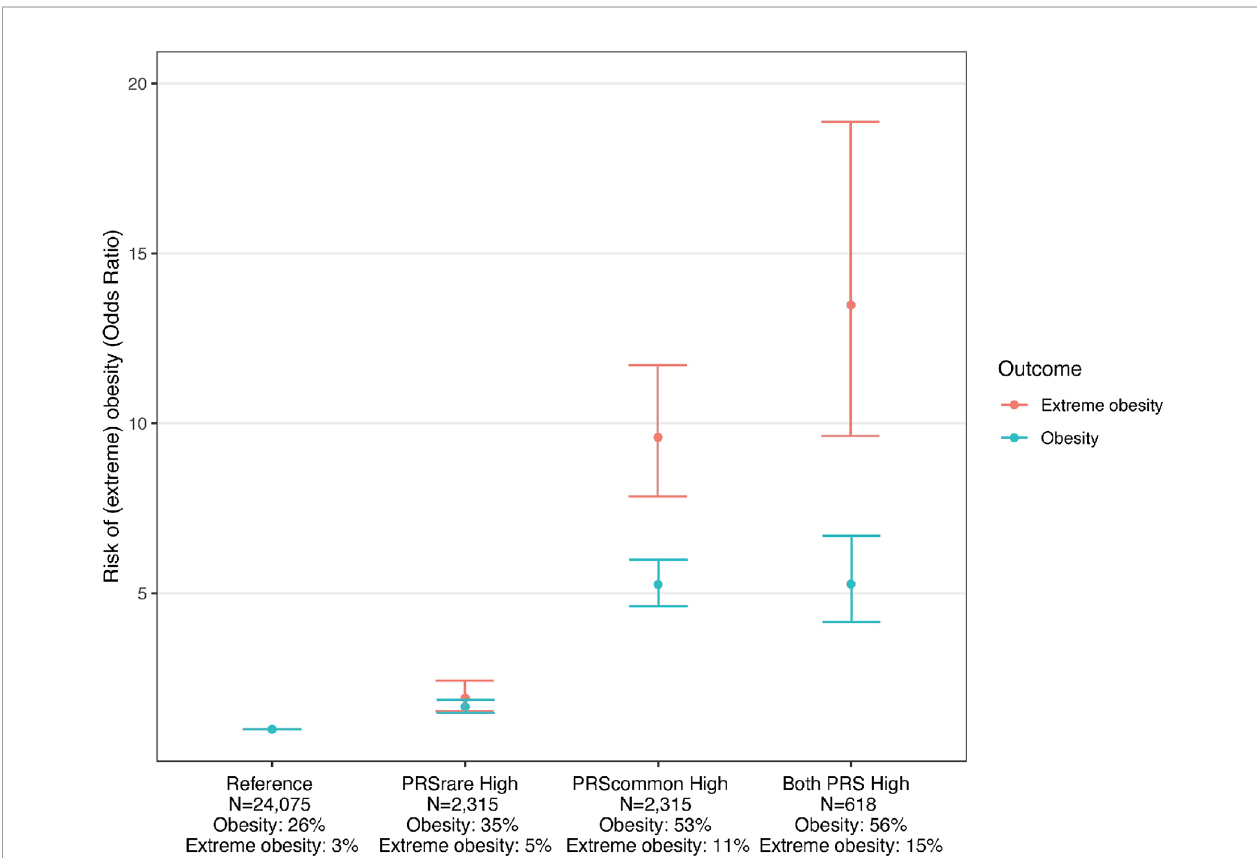
FIGURE 4 | Risk of obesity among individuals with high PRSrare and PRScommon. Reference: deciles 1-9 of PRS common and PRS rare , PRS rare High: top decile of PRS rare , PRS common High: top decile of PRS common , Both PRS High: top decile of PRS common and PRS rare